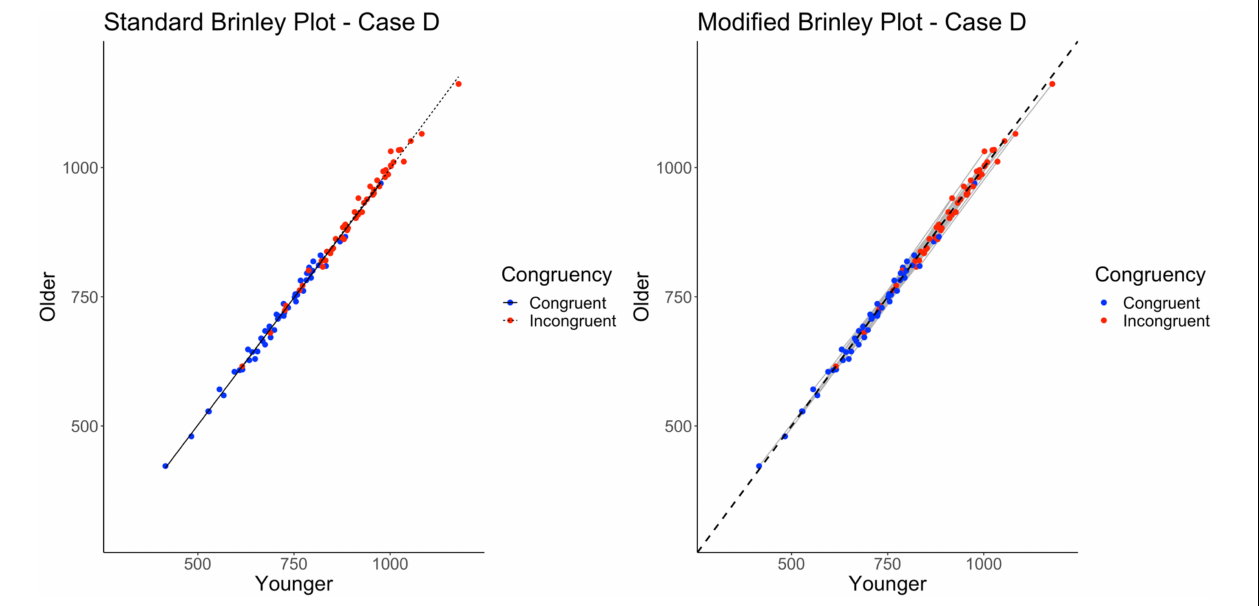
FIGURE 6 | Standard and modified Brinley plots—Case D data. Standard and modified Brinley plots (left and right, respectively) for the Case D simulated data which was simulated such that there was only a main effect of trial type present. Means (SD) used for Case D were as follows: Young Congruent = 700 (150), Young Incongruent = 900 (150), Old Congruent = 700 (150), Old Incongruent = 900